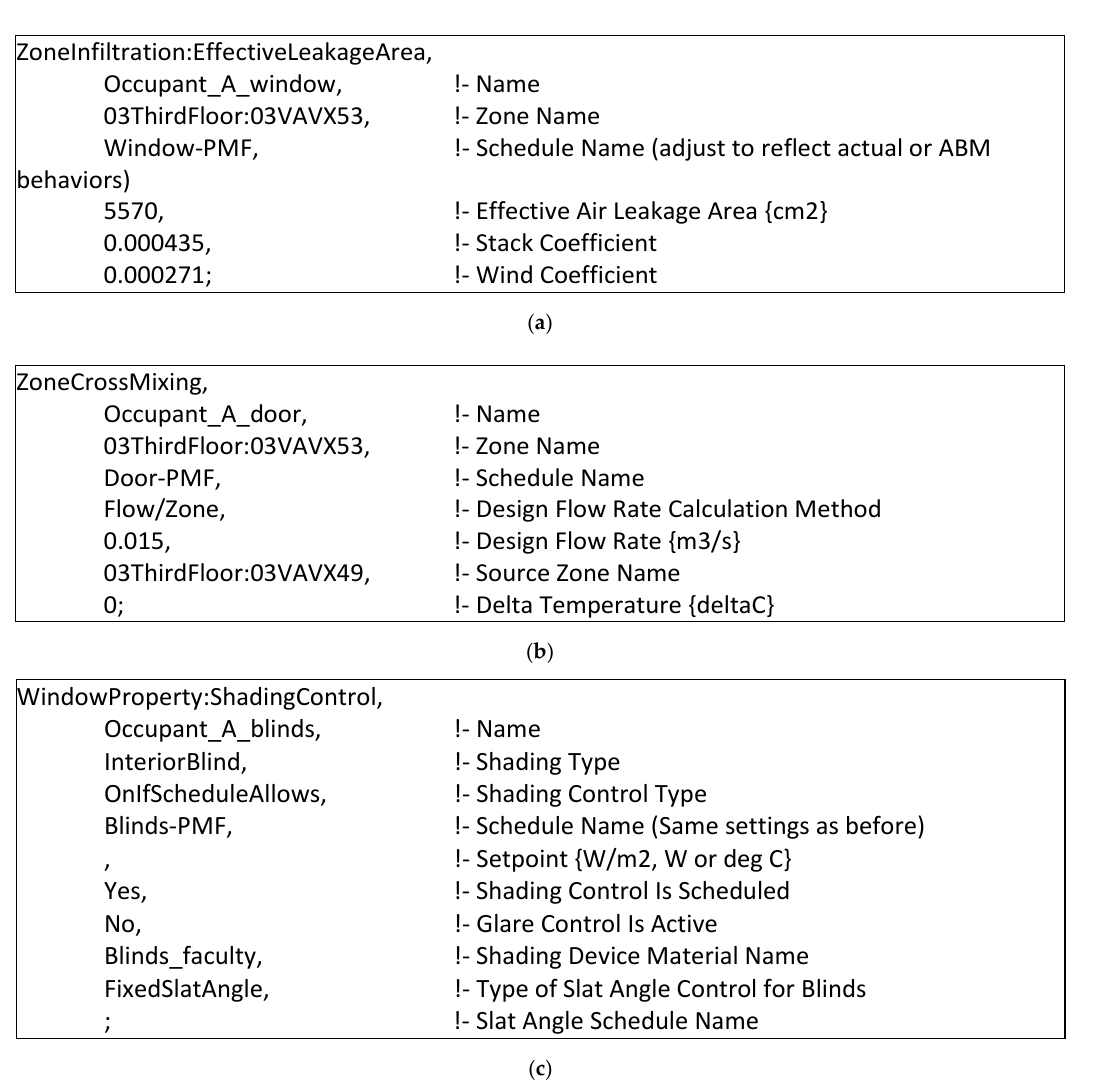
Figure 6. ( a ) Window operation variable settings for one occupant. ( b ) Door operation variable settings for one occupant. Figure 6. ( a ). Window operation variable settings for one occupant. ( b ). Door operation variable settings for one occu- ( c ) Window blinds operation variable settings for one pant. ( c ). Window blinds operation variable settings for one occupant.